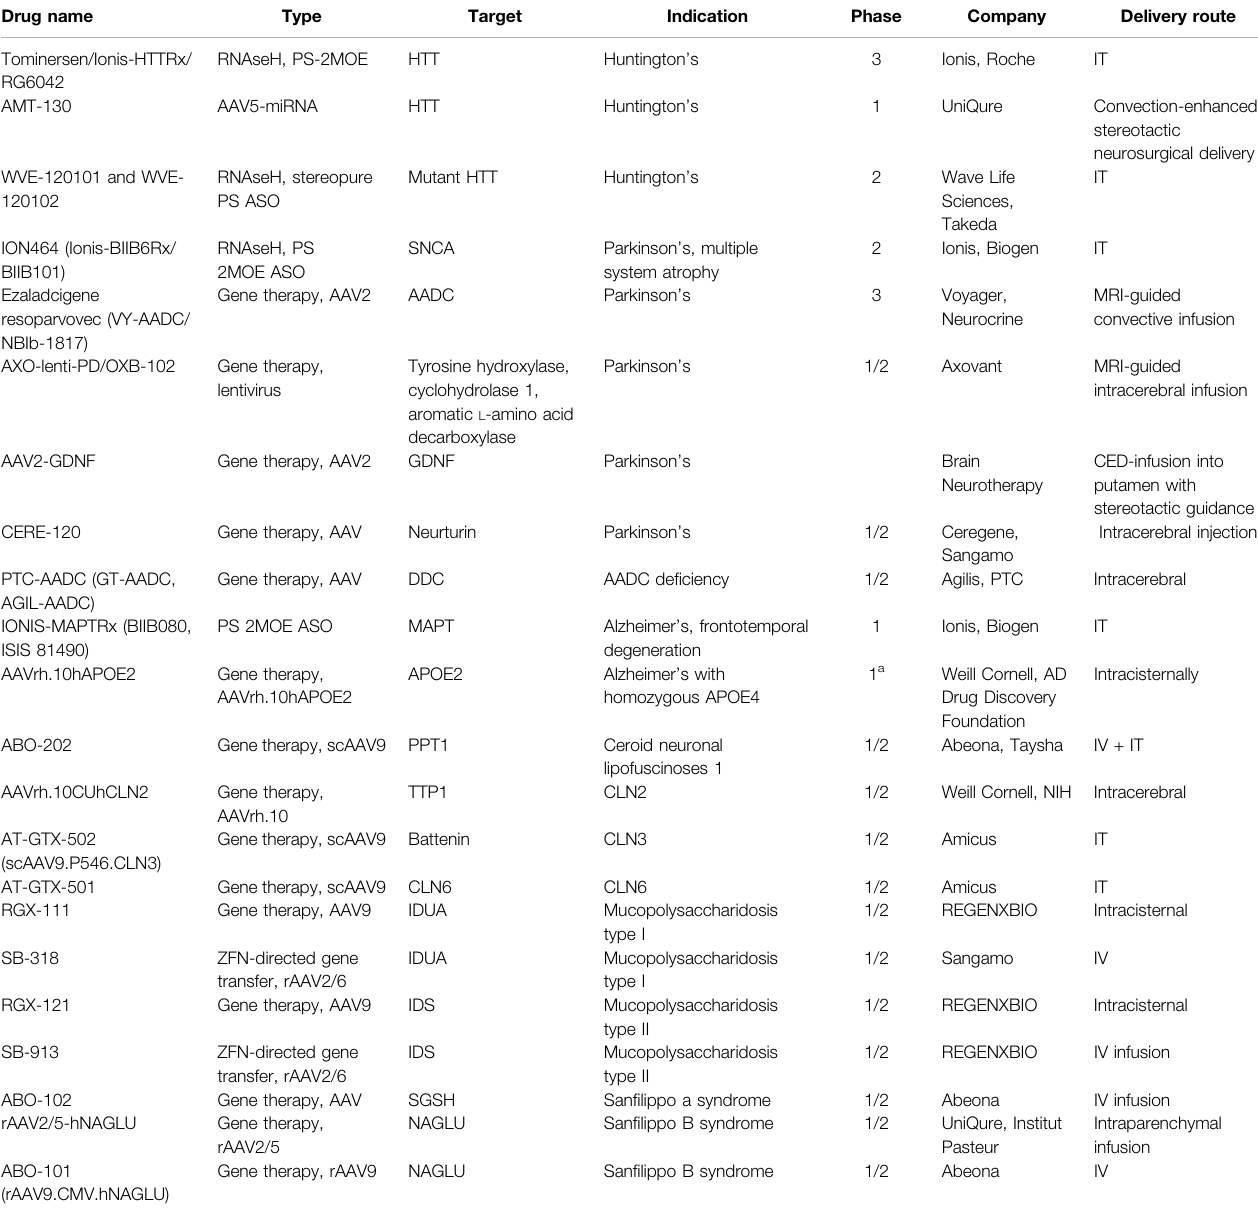
TABLE 2 | ( Continued ) Selected nucleic acid – based therapies in clinical trials as of November